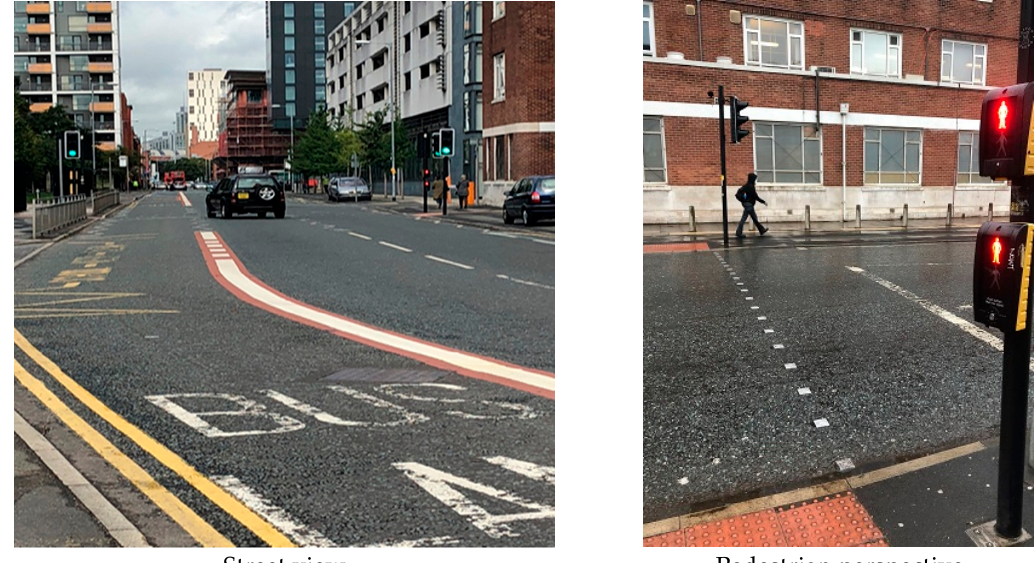
Figure 1. Views of the road crossing site .